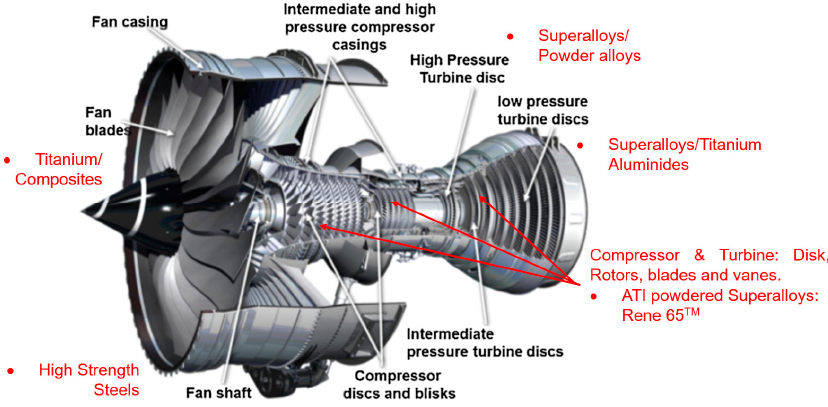
Figure 1. Some applications of Rene 65 in jet engine [4].